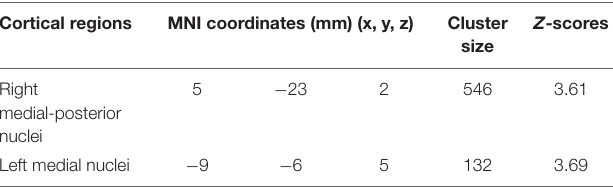
TABLE 2 | Coordinates of thalamic areas showing increased gray matter volume in NK refugees compared with SK